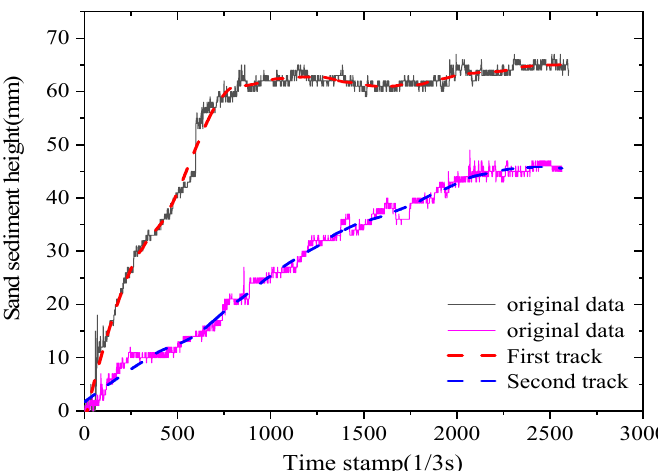
Figure 6. Variation of sand deposition volume on railway tracks. Table 1. Slope variation of curves of sand deposition height on the front of tracks.